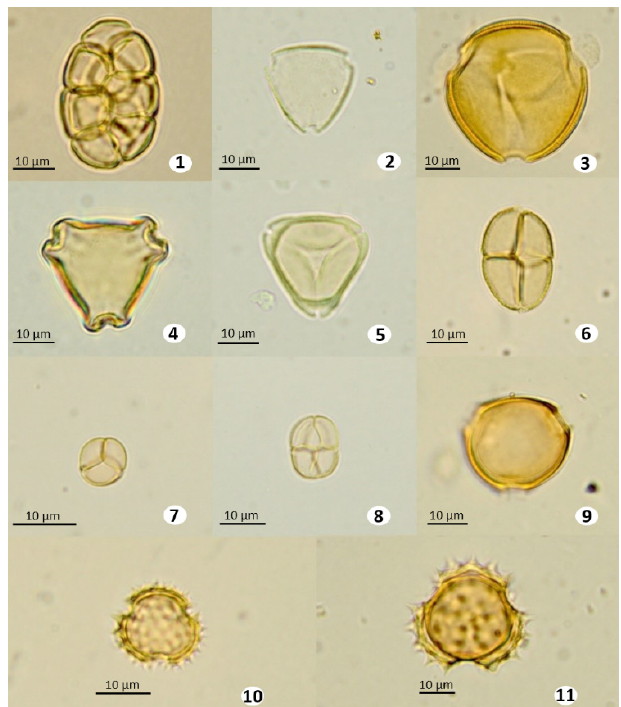
Fig 2. Principal pollen types found in honey samples of A. mellifera from Santa Helena and Terra Roxa, PR, 2008/2009 harvest: 1- Parapiptadenia rigida (Leguminosae-Caesalpinioideae); 2- Myrcia type (Myrtaceace); 3- Leucaena leucocep hala (Leguminosae- Caesalpinioideae); 4- Hovenia dulcis (Rhamnaceae); 5- Eucalyptus (Myrtaceae); 6- Mimosa verrucosa (Leguminosae-Caesalpinioideae); 7- Mimosa scabrella (Leguminosae-Caesalpinioideae); 8- Mimosa caesalpiniifolia ; 9- Glycine max (Leguminosae); 10- Mikania (Asteraceae); 11- Senecio